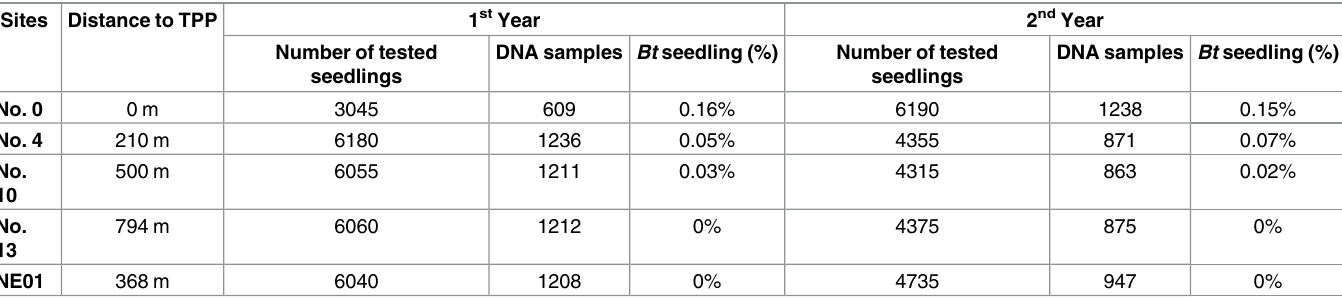
Table 1. Summaryof the proportion of seeds with Bt from sampled sites.